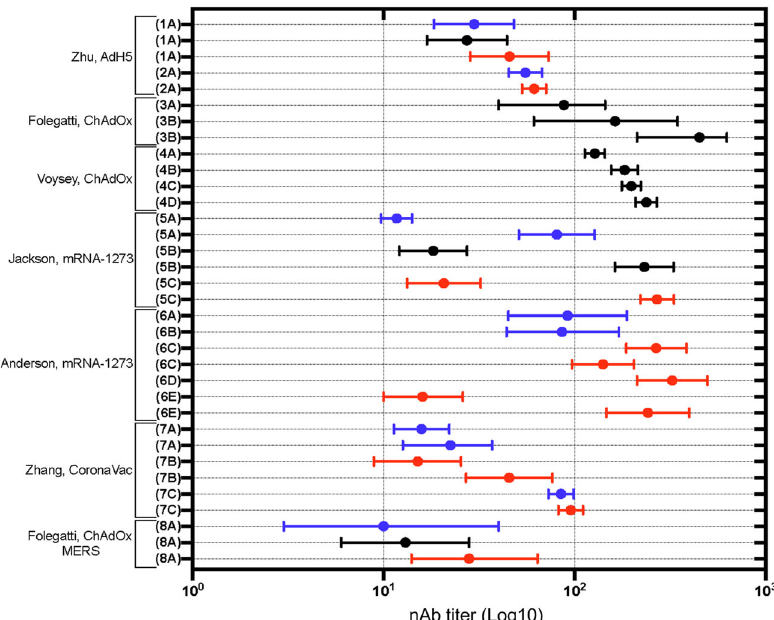
Fig. 7 Forest plot of pseudotyped nAb titres following HCoV vaccination in human studies. Blue = low; black = intermediate; red = high dose of vaccine indicated. Neutralizing antibody titre recorded circa 28 days post injection. Log transformed scale used. Vp Viral particles, GMT geometric mean titre, CI con fi dence interval, PFU plaque-forming units, GMET geometric mean endpoint titre, IQR interquartile range, CCID cell culture infectious dose, TCID tissue culture infectious dose, IC inhibitory concentration, SU SARS-CoV-1 units, ID infectious dose, IC inhibitory concentration. ( 1A ) Zhu, AdH-5 Phase 1: low dose — 5 × 10 10 vp, intermediate dose — 1 × 10 11 vp, high dose — 1.5 × 10 11 vp; VSV pseudovirus system expressing spike protein; expressed as GMT (95% CI); ( 2A ) Zhu, AdH-5 Phase 2: low dose — 1 × 10 11 vp, high dose — 5